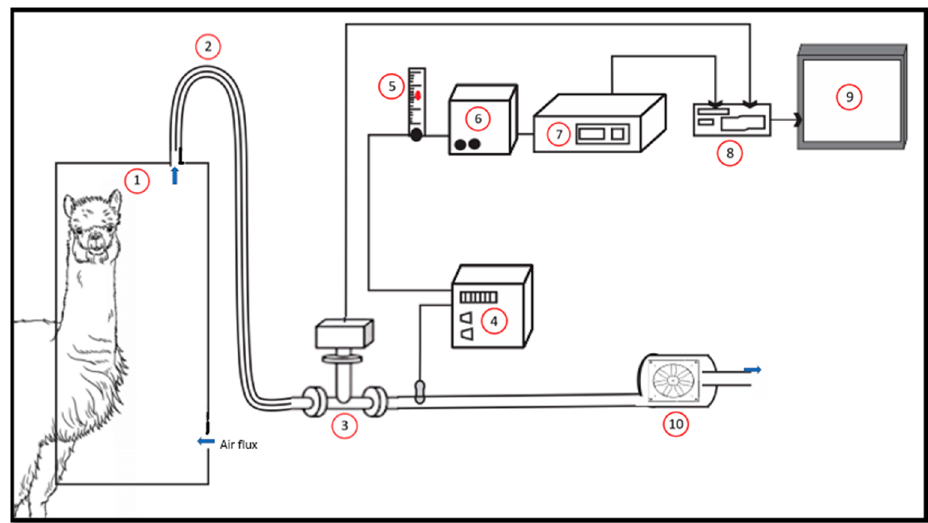
Figure 2. Schematic diagram of the mobile open-circuit respirometry system: (1) head hood, (2) high pressure hose, (3) flowmeter, (4) gas cooler, (5) rotameter, (6) diaphragm pump, (7) gas analyzer, (8) data logger, (9) integrated computer, and (10) fan.